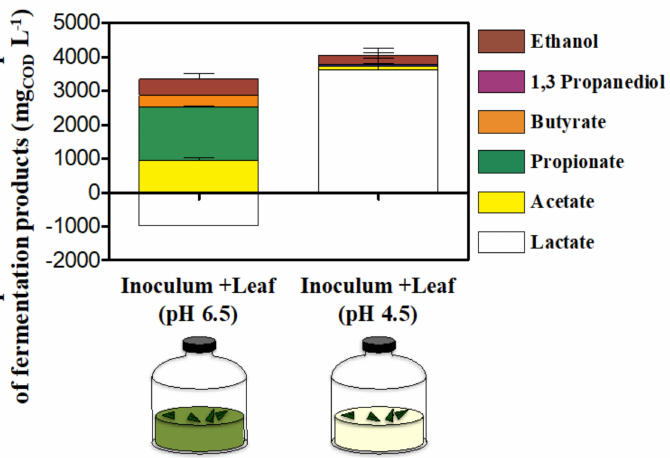
Figure 5. Timeline of gas production of H 2 ( A ) and CO 2 ( B ) in In vitro tests inoculated with gut microbiomes from giant panda fecal samples at different initial pH (either 6.5 or 4.5). The dotted line represents the longest retention time observed in vivo in giant pandas [8]. Inlet in Figure 5A: timeline of pH during incubation. Keys reported in the graph.